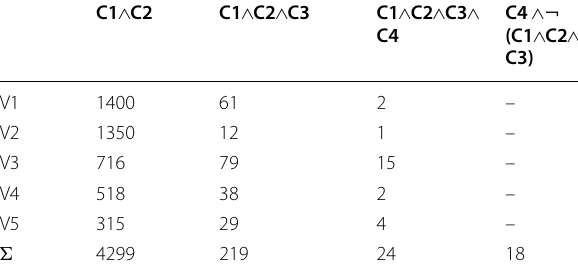
Table 1 Numbers of papers per criterion and